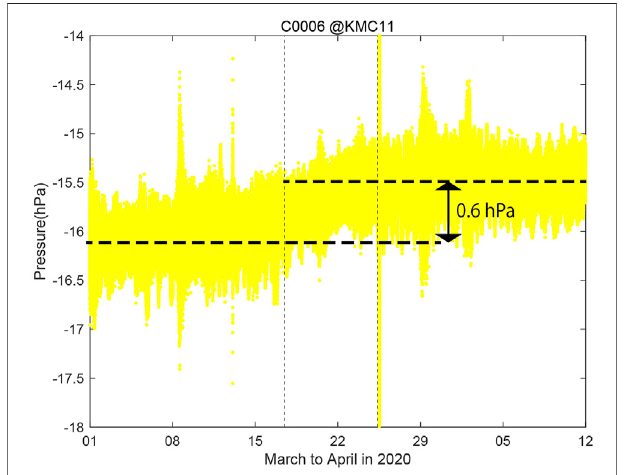
FIGURE 9 | Close up of pore pressure history at C0006 before and after theSSEinMarch2020byapplyingKMC11tothereferencesea fl oorpressure. Vertical double arrows represent change amount during the SSE.